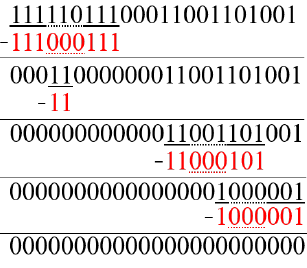
Figure 6: An example of the process of CWM ( L = R = s =